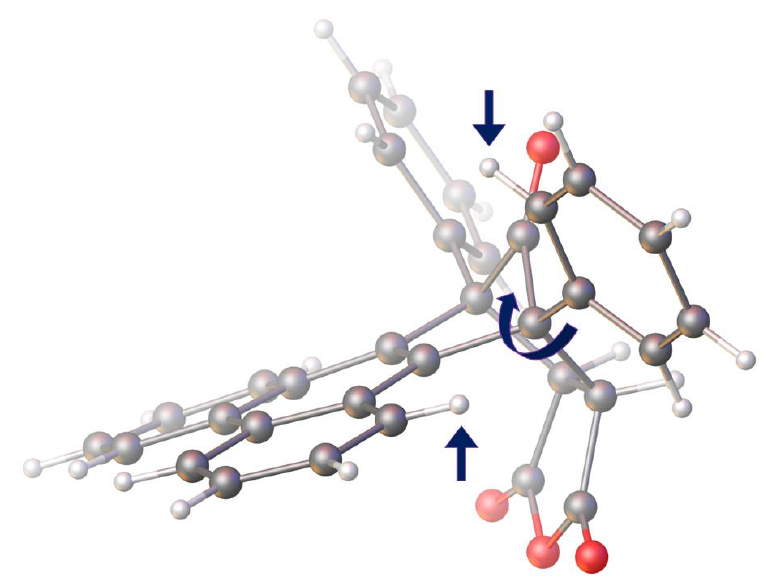
Figure 3. Illustration of the protons associated with steric interactions that result in the restricted rotation of bridgehead phenyl group.